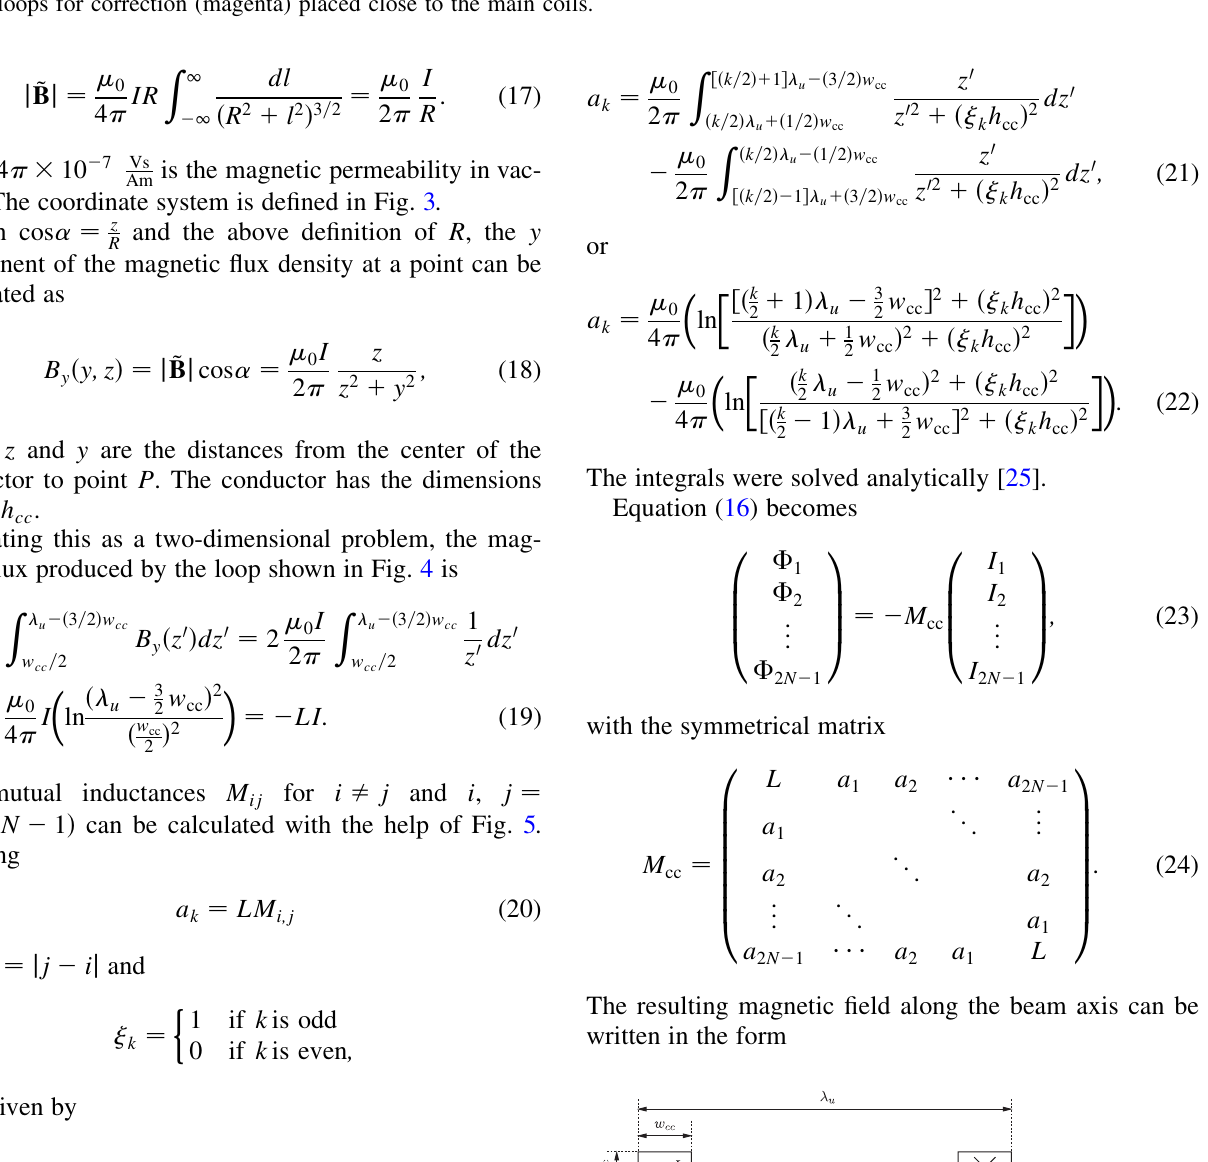
FIG. 3. (Color) Cross section of an undulator with the main coils (green, iron; red, superconductive wire bundles) and overlapping closed loops for correction (magenta) placed close to the main